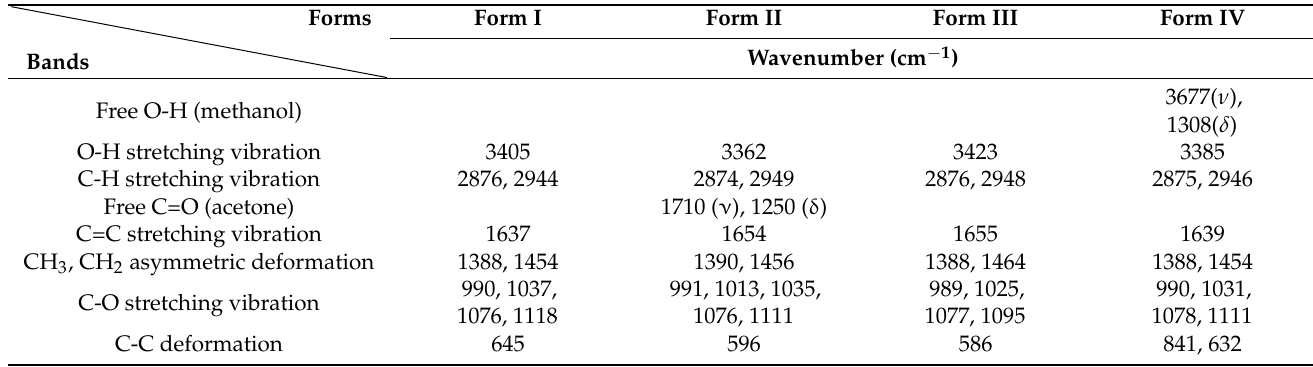
(2 θ ). Form I was in an amorphous state, and forms II, III, and IV were in crystalline structures. Table 1. FTIR spectra of specific bands of the four forms of